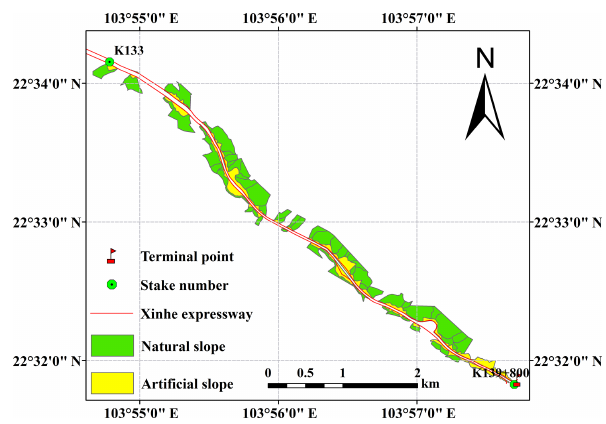
Figure 3. Division results of the prediction units (A subset